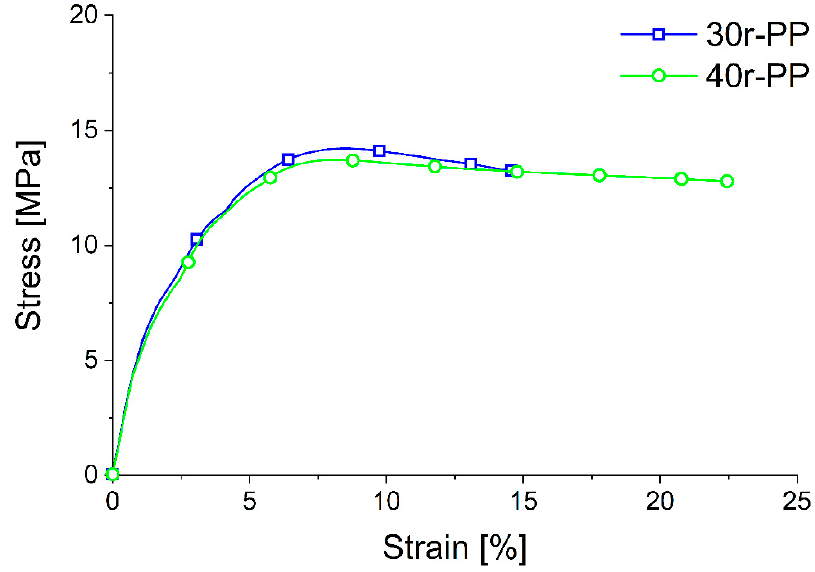
Figure 6. Stress-strain curves for 30r-PP and 40r-PP FFF-printed samples. Table 5. Main mechanical properties for 30r-PP, 40r-PP, and a commercial PP sample. Table 5. Main mechanical properties for 30r-PP, 40r-PP, and a commercial PP